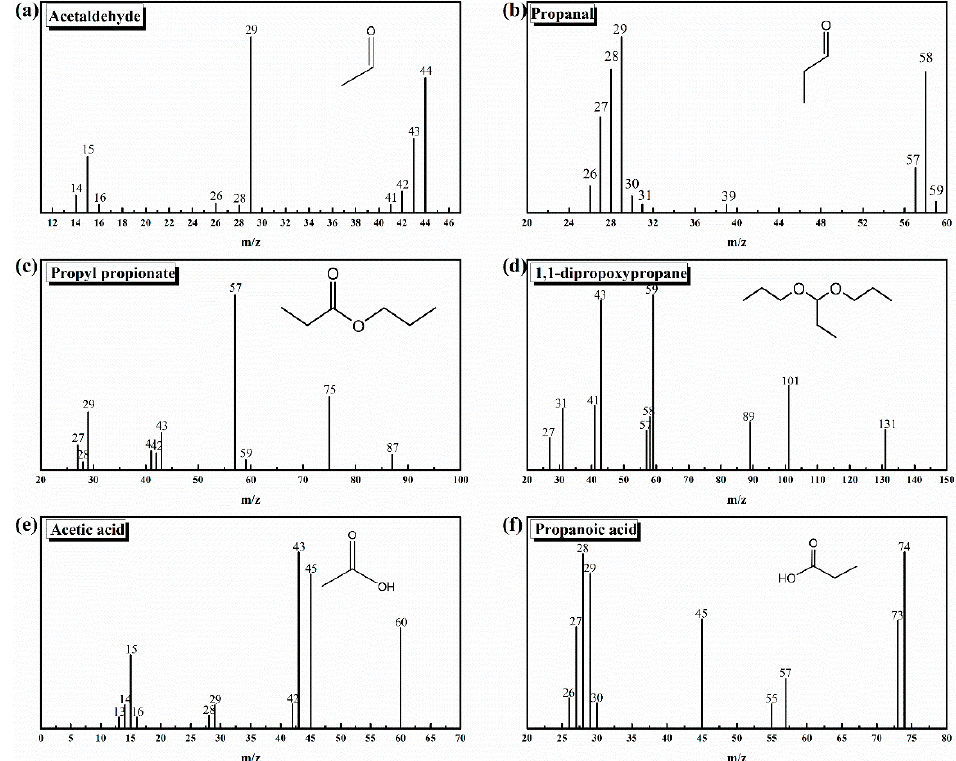
Figure 3. Mass spectra of impurities derived from electron impact ionization of I-ink: ( a ) acetaldehyde; ( b ) propanal; ( c ) propyl propionate; ( d ) 1,1-dipropoxypropane; ( e ) acetic acid; ( f ) propanoic acid. Table 2. Summary of impurity concentrations of the catalyst inks derived from GC-MS data. Sample Acetic